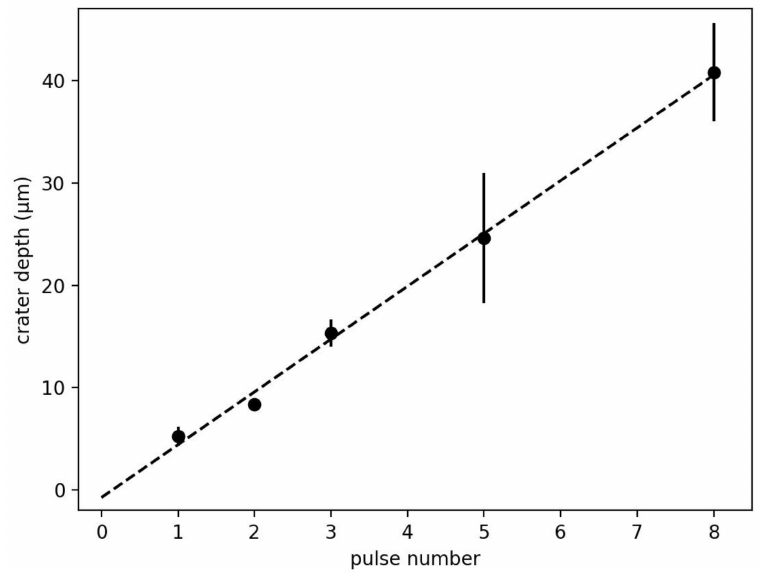
Figure 3. Crater depth as a function of the pulse number. Three measurements were done per pulse number; the error bar shows the standard deviation. The fit parameters are: slope 5.15 µ m per pulse, offset − 0.73 µ